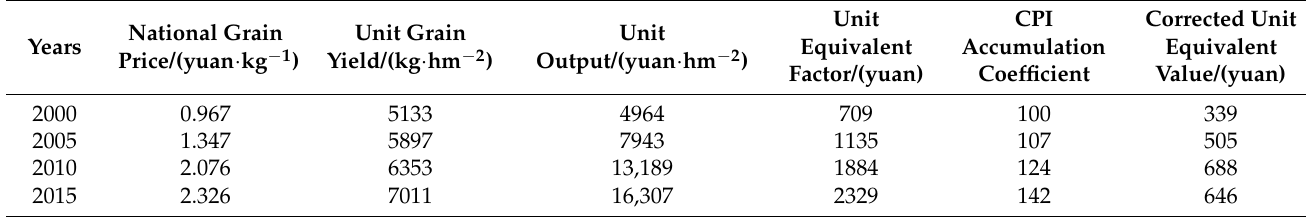
Table 2. Equivalent value table of ecological services per unit